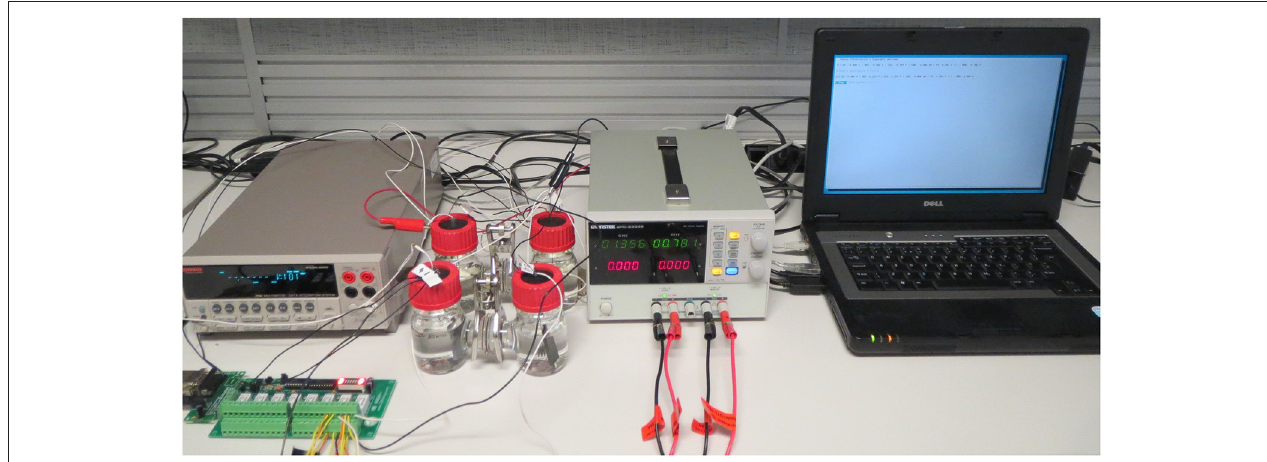
FIGURE 1 | Complete experimental setup with two potentiostat channels. From left to right: digital multimeter (in the back), relay board (in front), two H-type electrolysis cells, power supply, control computer.